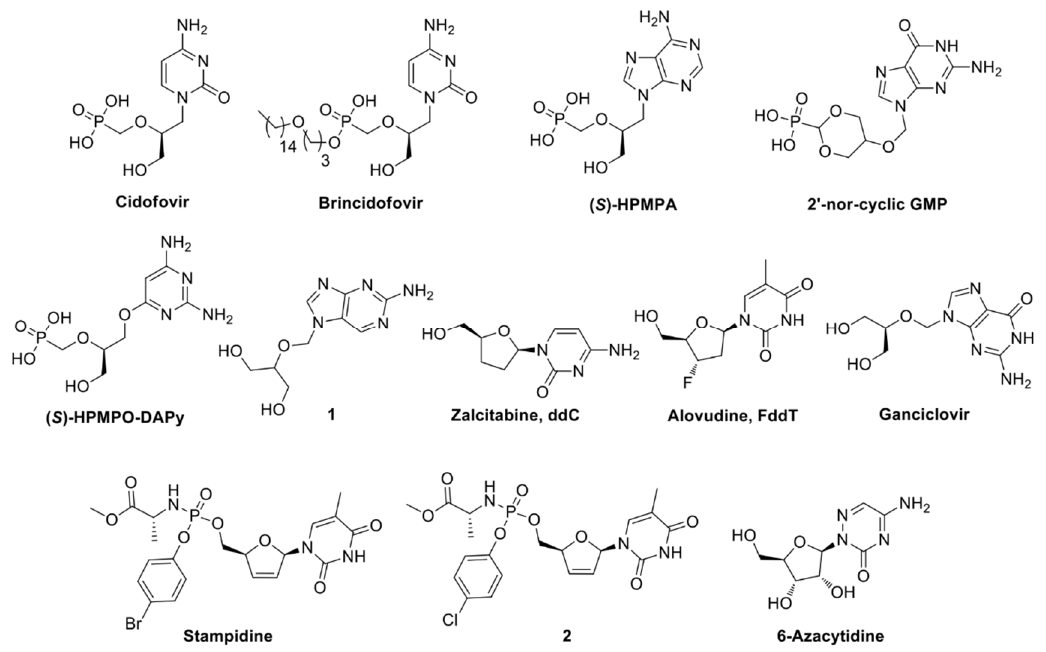
Figure 7. Nucleoside analogues inhibiting HAdV pol/HAdV replication.